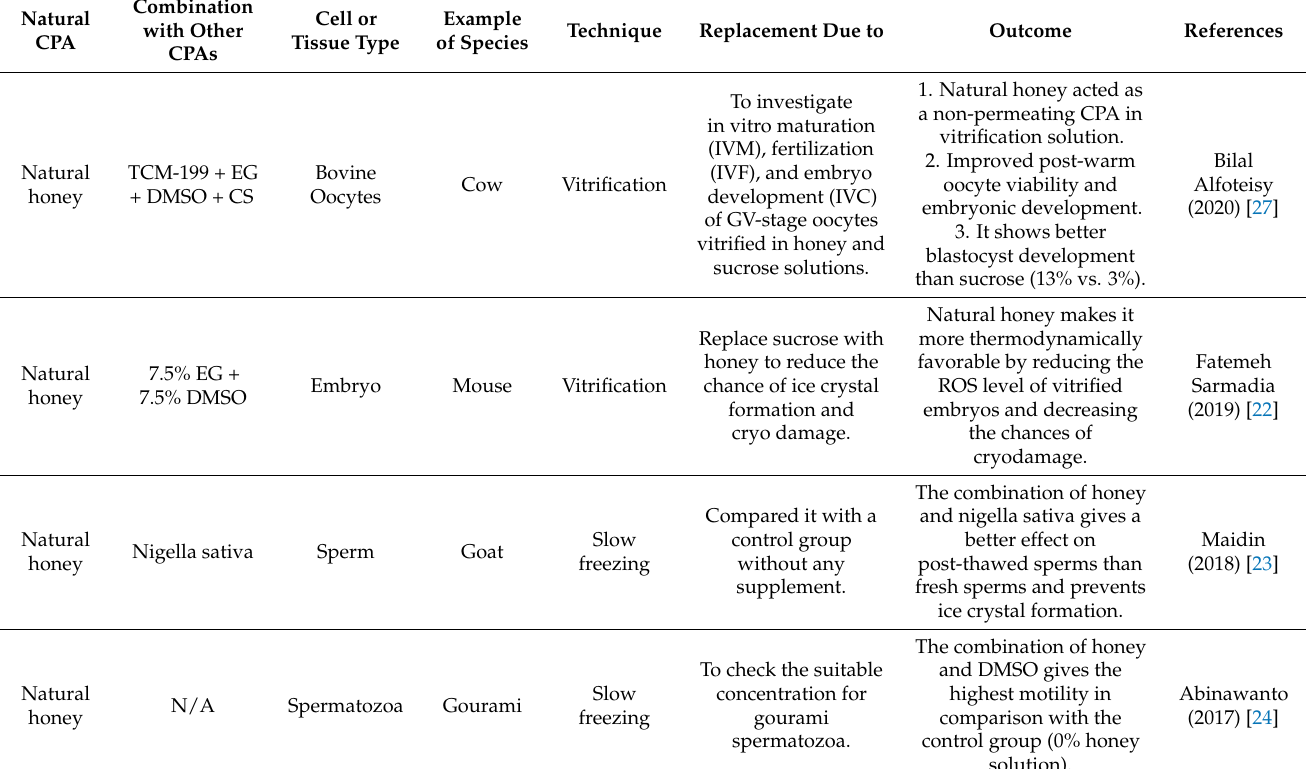
Table 1. Selective studies for fertility cryopreservation using natural cryoprotectant